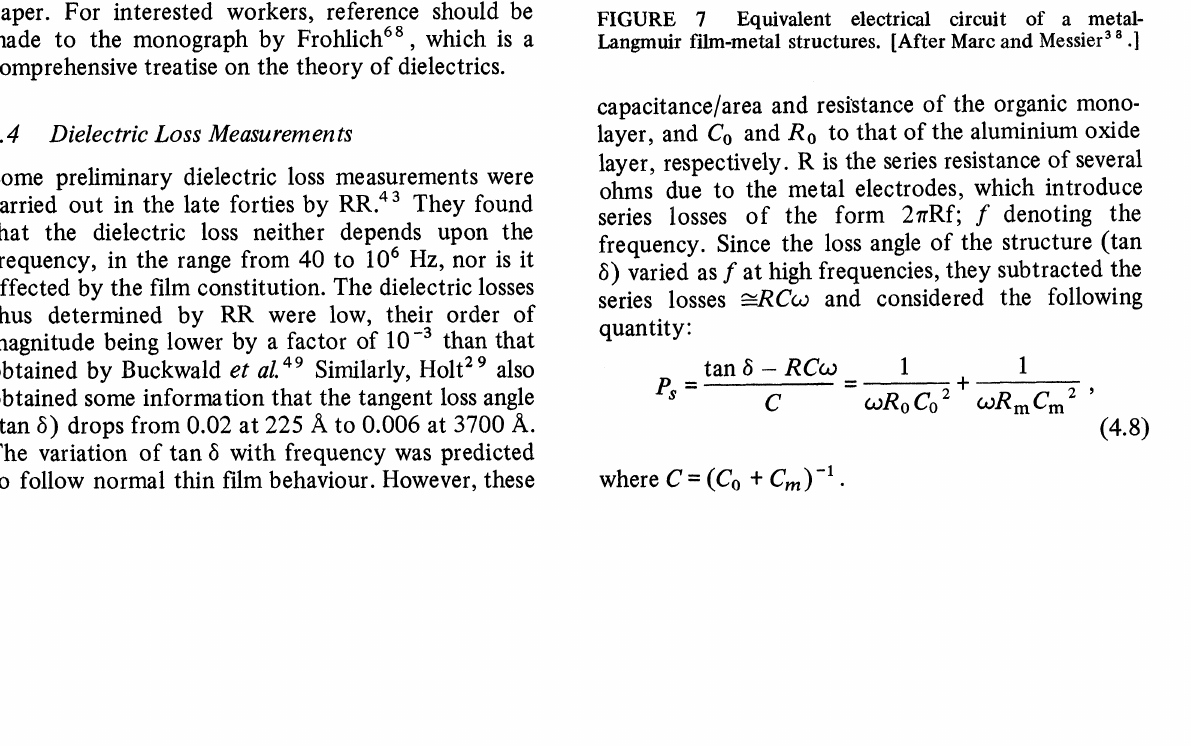
L R m Cm Equivalent electrical circuit of a metal- Langmuir film-metal structures. [After Marc and Messier